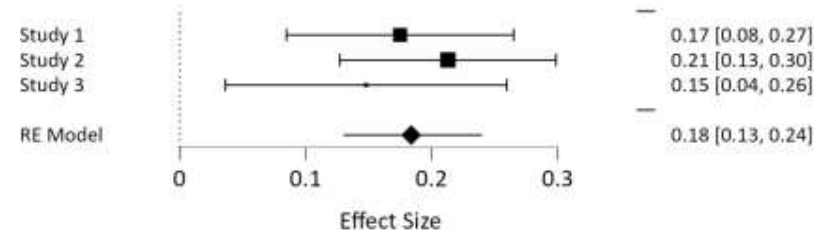
Figure 12 . Forest plot of meta-analysis of Motivation for knowledge and Agreeableness Motivation for achievement has a mild but significant positive correlation with the dimensions of Extraversion, Intellect, Agreeableness and Conscientiousness.